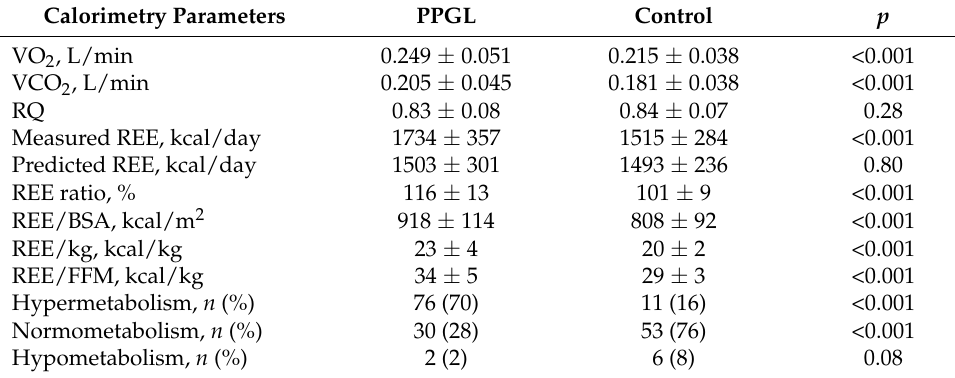
Table 2. Indirect calorimetry results between PPGL and control groups.